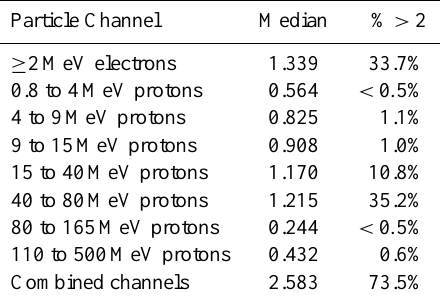
Table 2. Analysis of perceived to actual age ratios. The left col- umn lists the eight GOES EPS particle/energy channels used in this study. The center column lists the average ratio of perceived age to chronological age for all 1609 anomaly events. The rightmost col- umn lists the percent of the events whose age ratio exceeded